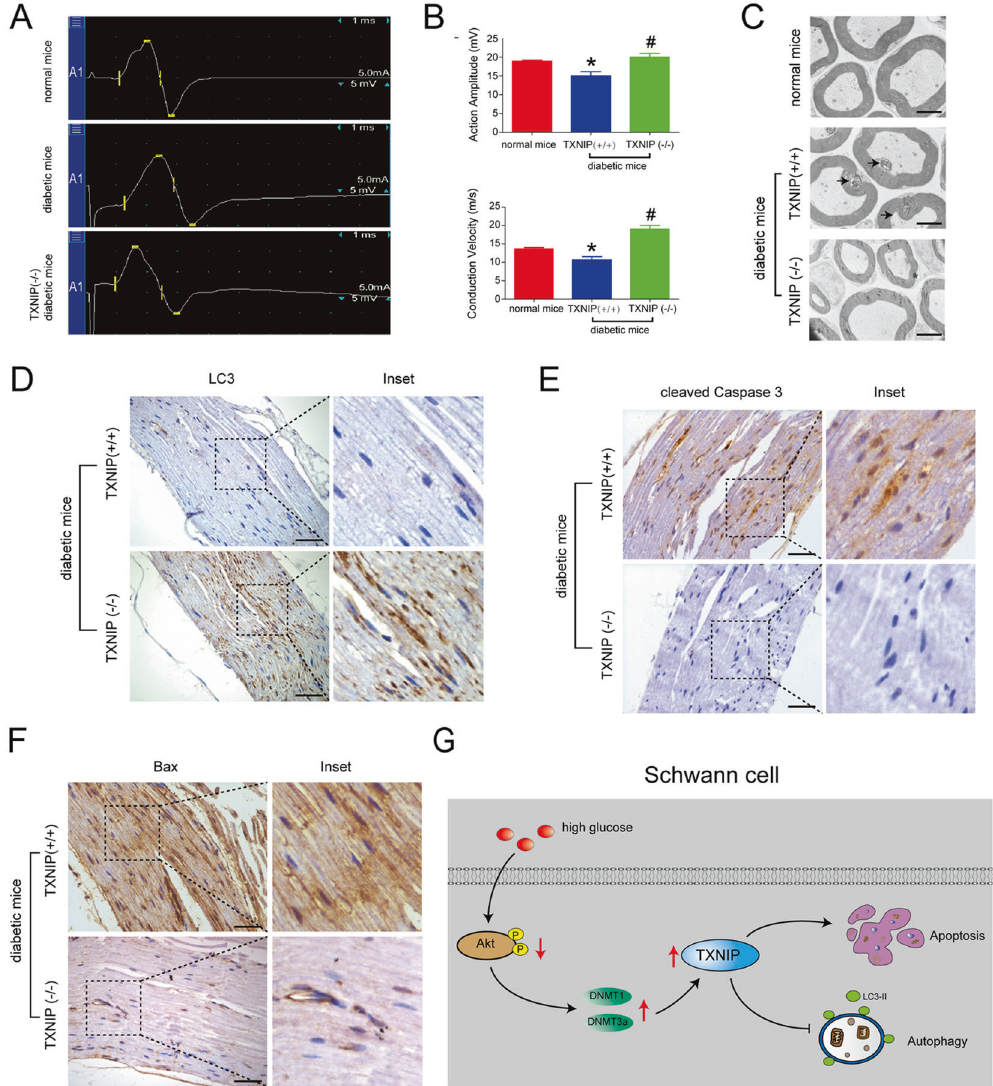
Fig. 7 Knockout of TXNIP in vivo ameliorated cell autophagy and improved nerve conduction function in the sciatic nerve of diabetic mice. A , B Electrophysiological detection of action amplitude and conduction velocity of the sciatic nerves of diabetic mice with TXNIP ( + / + ) and TXNIP ( − / − ). * P < 0.05 versus normal mice. # P < 0.05 versus TXNIP ( + / + ) diabetic mice. C Electron microscope observation of myelin sheath in the sciatic nerves of diabetic mice with TXNIP ( + / + ) and TXNIP ( − / − ). Black arrows showed infoldings. Bar: 1000 nm. D inset was shown with dashed square. Bar: 50 μ m. F Immunohistochemistry of Bax in the sciatic nerves of diabetic mice with TXNIP ( + / + ) and TXNIP ( − / − ). The inset was shown with dashed square. Bar: 50 μ m. G Model of the regulation of high glucose on the phospho-Akt, DNMTs, TXNIP, apoptosis, and autophagy in Schwann